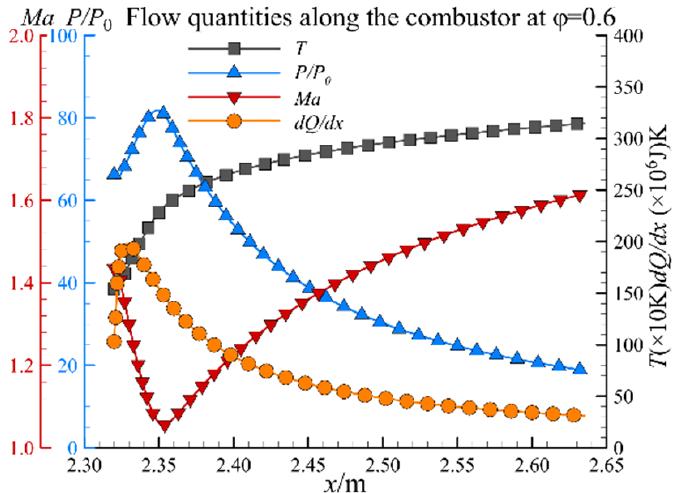
Figure 8. Flow quantities along the combustor at φ = 0.60.